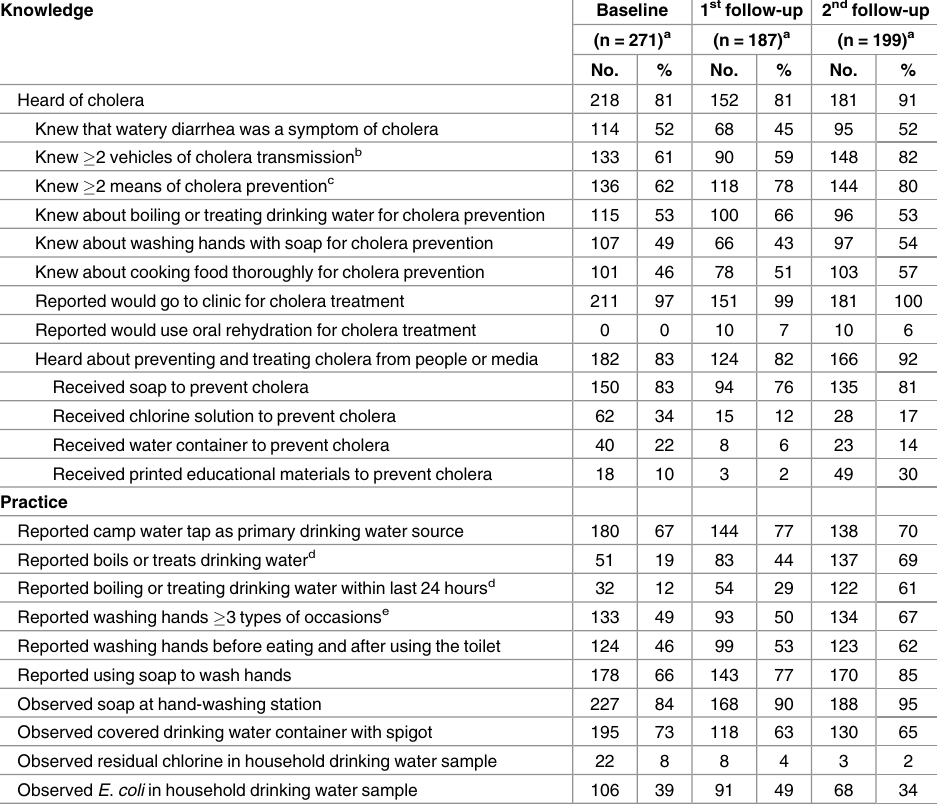
Table 3. Knowledge and practicesabout safe water, sanitation and hygiene in surveys conducted 1 month before (baseline), and 3 and 12 months after (first and second follow-up) an oral cholera vacci- nation campaign, Maela Camp,